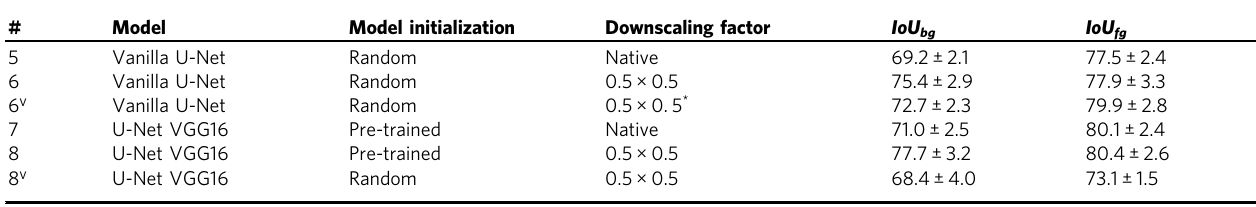
Table 2 Intersection over Union metrics of U-Net-based networks trained on the scanning electron microscopy data set for different model initializations and downscaling factors.